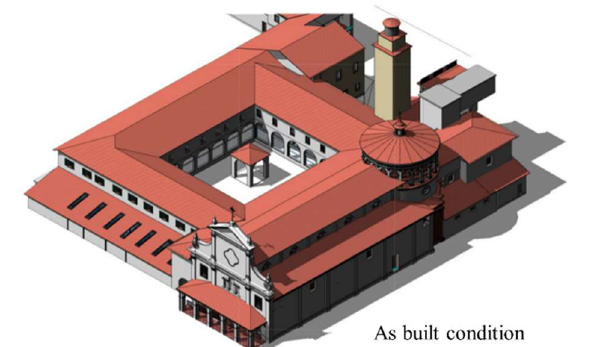
Figure 17. HBIM model in progress, realized on the base of the TLS and UAVs